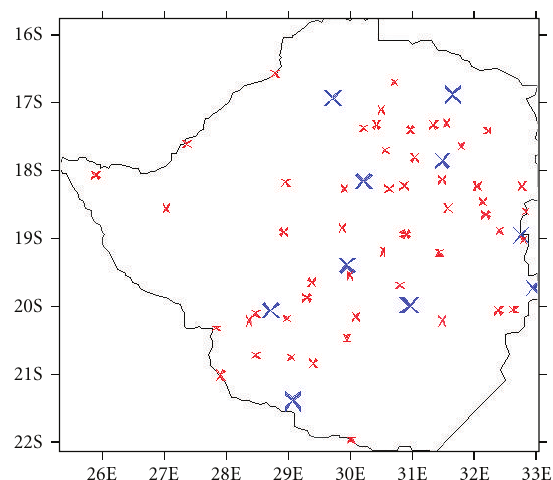
Figure 2: Location of 60 rainfall stations used in the study. Bigger crosses are for stations with more than 100 years of rainfall